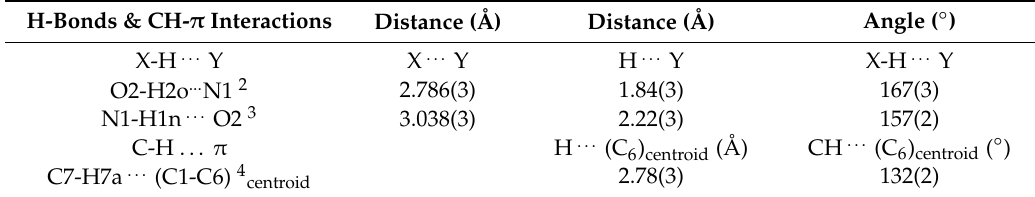
Table 2. Selected intermolecular interactions in BE_IV 1 .